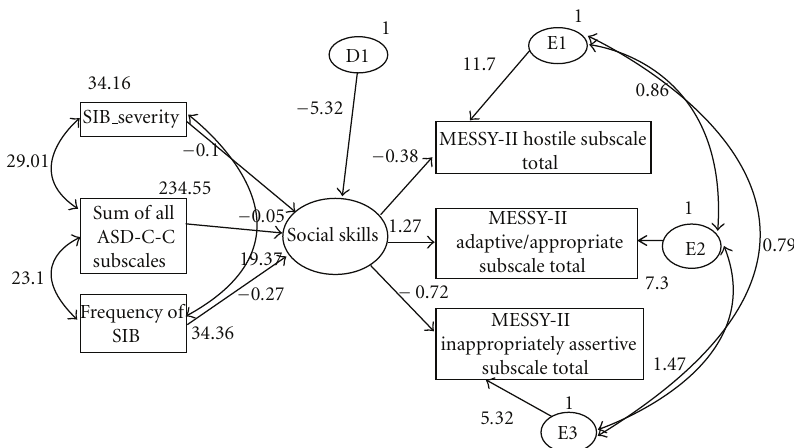
Figure 1: Structual equation model for SIB, cooccuring behaviours and social deficits for children and adolescents with ASD. N = 95 . χ 2 = 3 . 415 , df = 4, P = . 491, relative chi-square (.854), GFI (.988), CFI (1.000), RMSEA (.000) and P Ratio (.267). All pathways were significant with P < . 05, and standardised coe ffi cients were shown next to each pathway. Latent variables in oval and manifest variables in rectangle